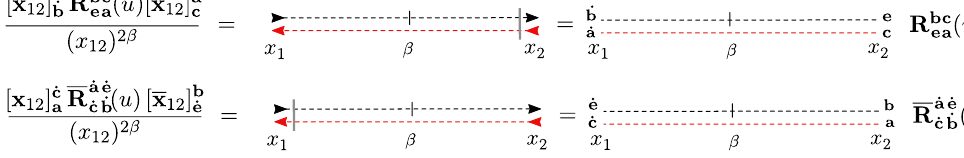
( u, x ) of (2.26). The two dashed lines 1 − x 2 ‘ ˙ ‘ ( u, x ) , 1 − x 2 ‘ ˙ ‘